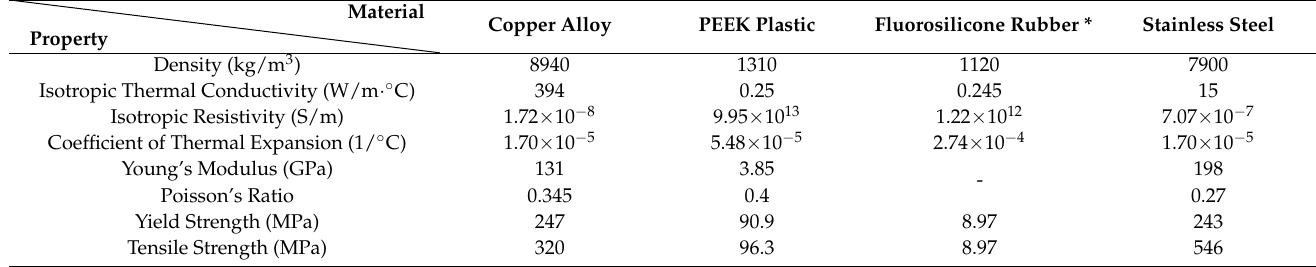
Table 2. Material specifications of the proposed wet-mateable electrical